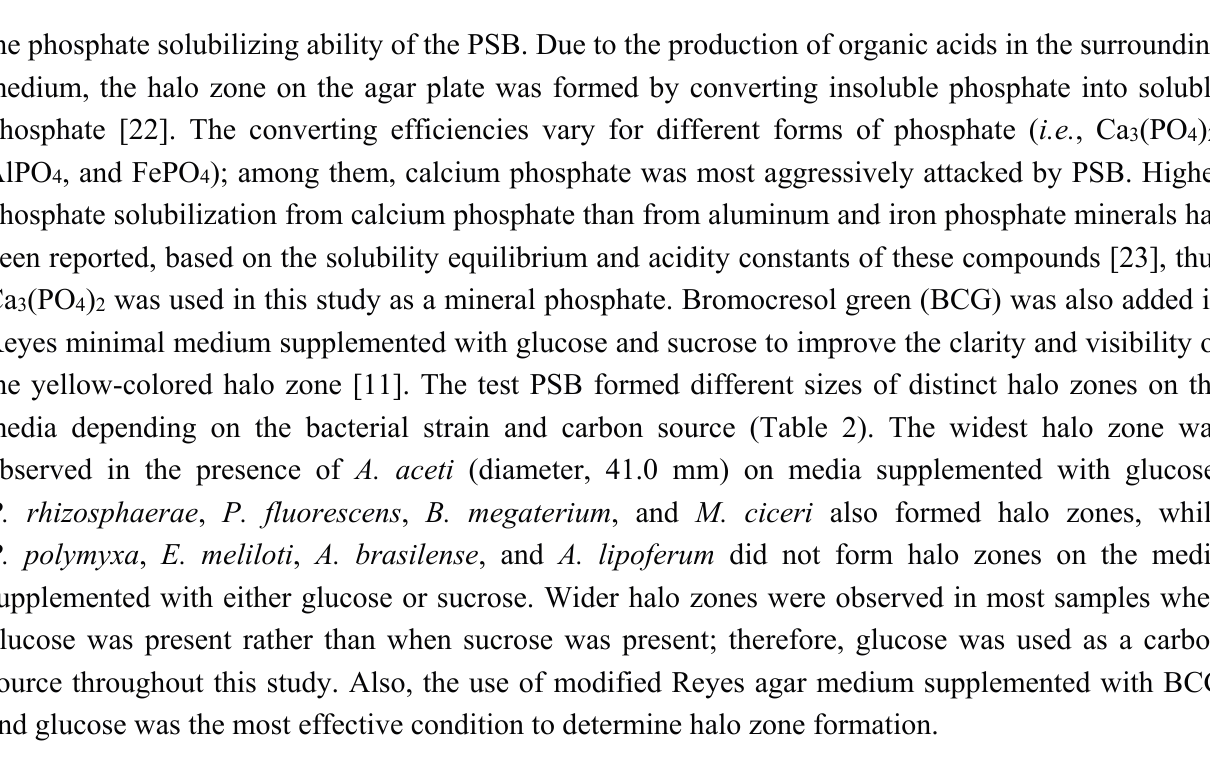
Table 2. Comparison of tricalcium phosphate solubilization by phosphate solubilizing bacteria (PSB) in Reyes minimal agar medium supplemented with bromocresol green (BCG) and 30 g/L of glucose or sucrose, associated with microbial growth for 24